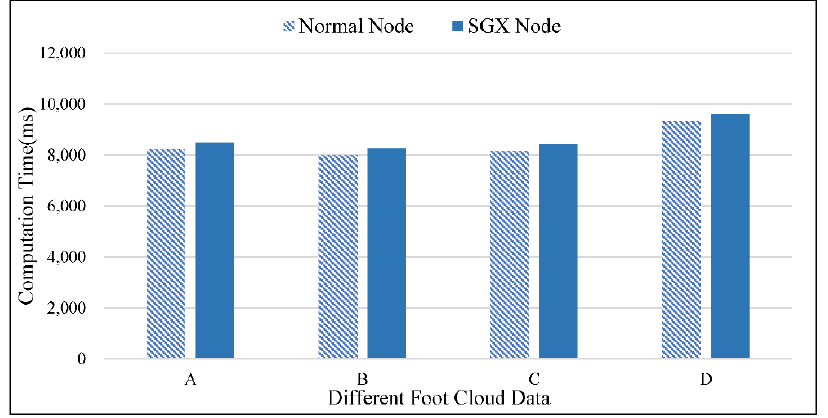
Figure 9. The computation performance comparison between ordinary environment and TEE.